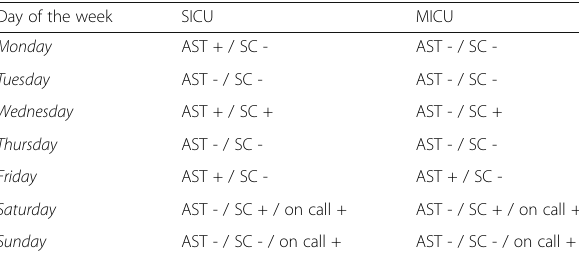
Table 1 (abstract 0389). Timing of AST meetings, availability of surveillance cultures and routine microbiological services